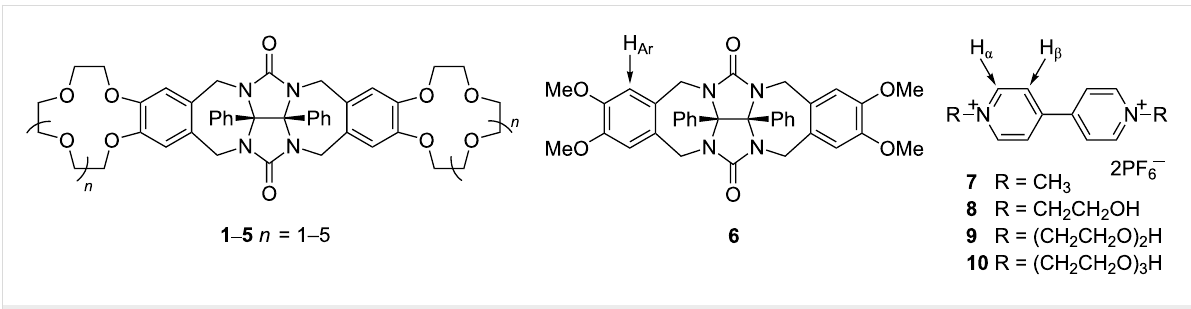
Figure 1: Chemical structures of hosts 1 – 6 and guests 7 – 10 .